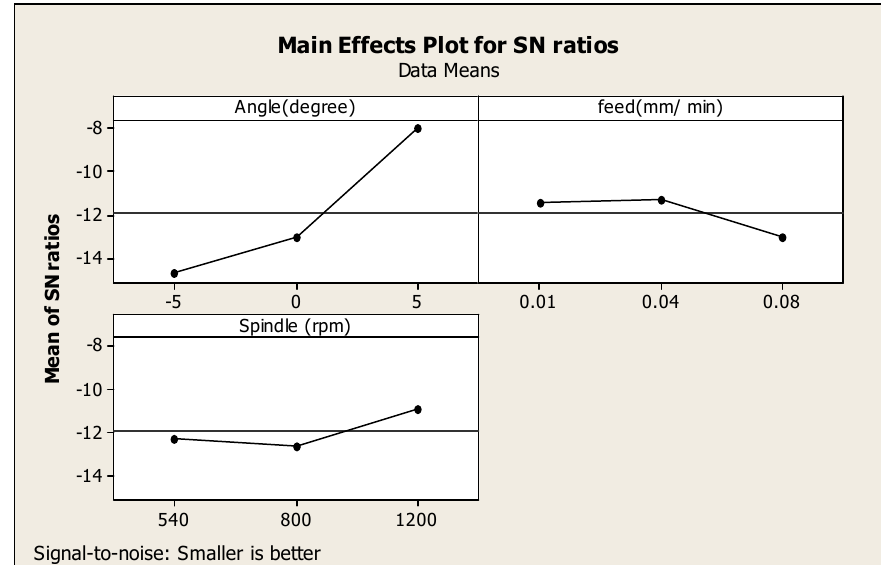
Fig. 3. Plot for signal to noise for brass .